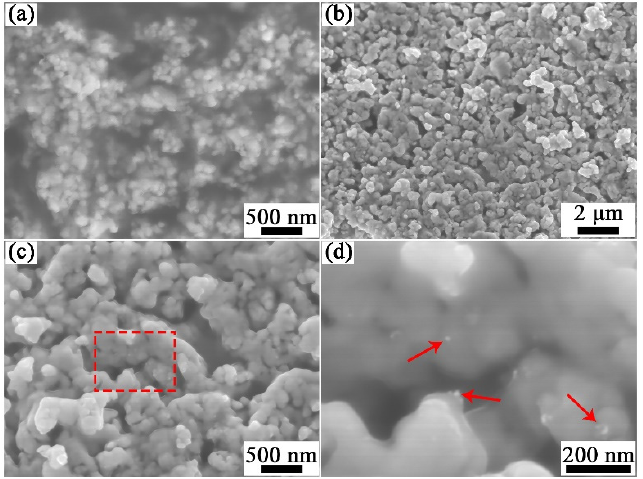
Figure 2. SEM images of ( a ) sol-gel synthesized precursor powders, ( b , c ) hydrogen reduced Cu-1wt%Y 2 O 3 powders at 400 °C for 1 h, and ( d ) magnification of the region marked with red dotted line in ( c ).